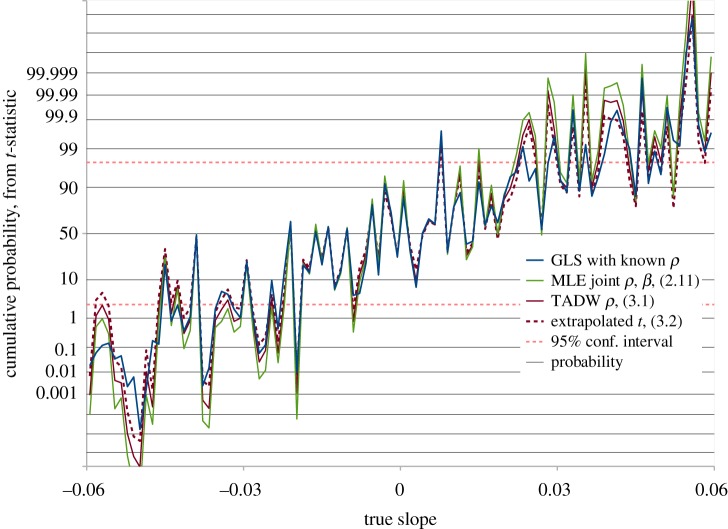
GLS regression slope t-values for 100 randomly generated datasets, each with 100 data points, consisting of AR1(ρ = 0.75) noise ϵi=N(0,1)+ρ⋅ϵi−1, plus a known slope. Here, N(0, 1) is a zero mean unit variance normally distributed variate. We set ϵ1=N(0,1)/1−ρ2, to ensure stationarity. The GLS calculation is performed both with known and estimated values of ρ. The MLE (green trace) |t| exceeds the known ρ |t| for 77% of these trials, while the extrapolated (dashed brown trace) |t| from (3.2) exceeds the known ρ |t| in 38% of cases.